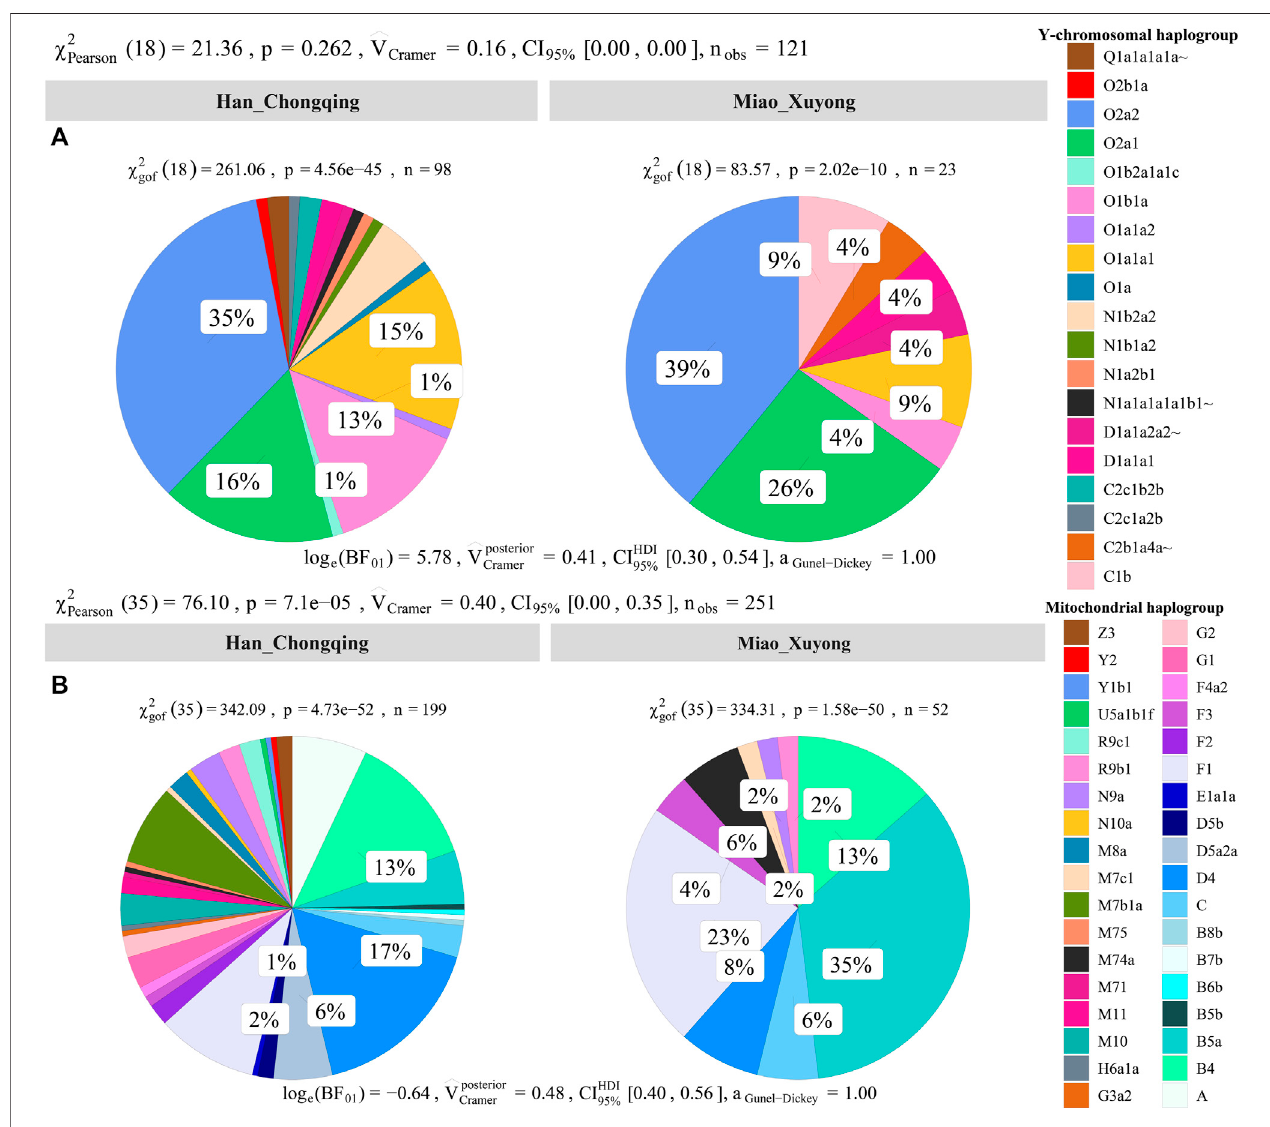
FIGURE 7 | Allele frequency spectrum of observed maternal and paternal haplogroups of Chongqing Miao and Chongqing Han. Population comparison between Han and Miao based on the frequency distribution of the observed paternal lineages (A) and maternal lineages (B) via the Pearson and Cramer tests.